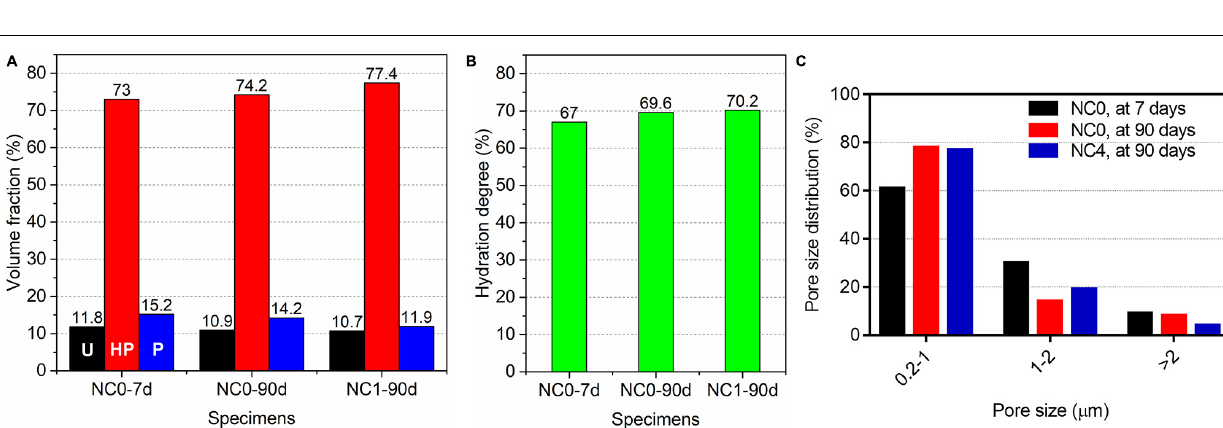
Frontiers in Materials |